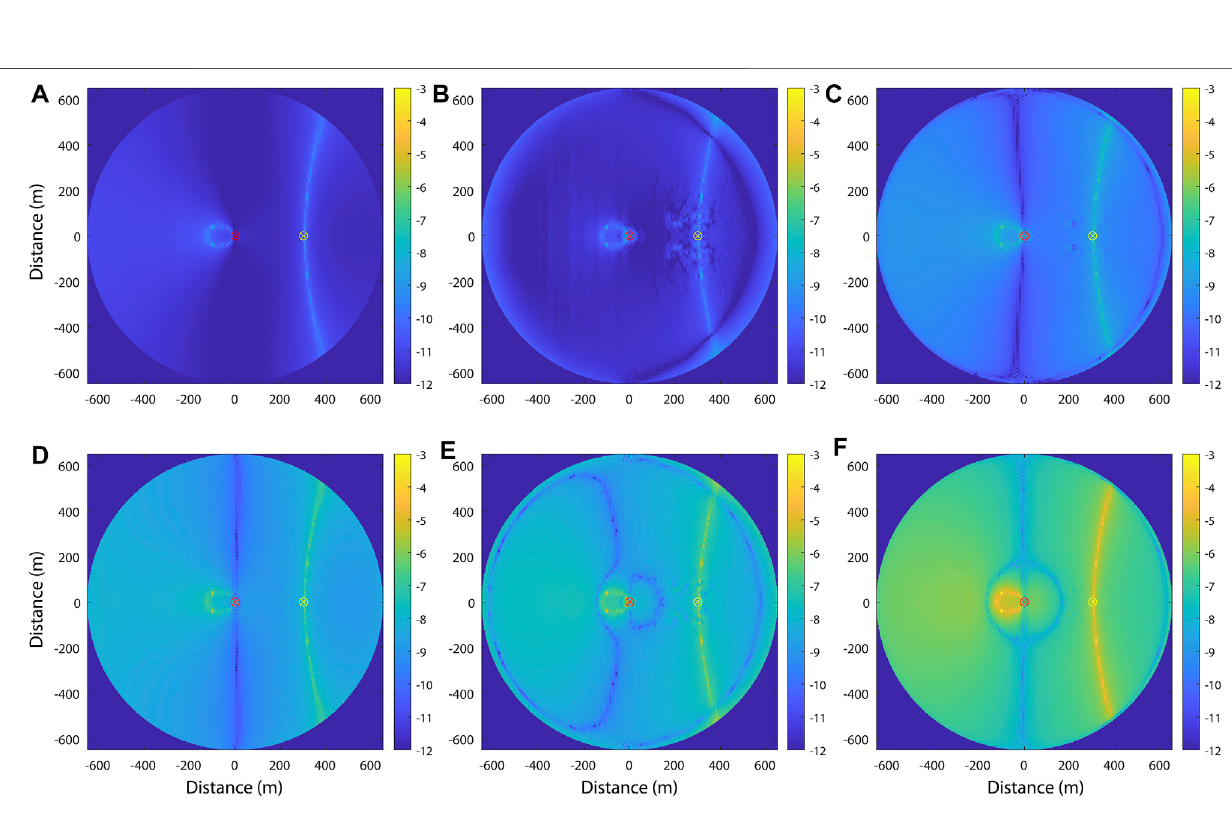
sample holder was used to scan the sample between 2 and 55 ° (2 θ ) using a Cu-K α source (giving x-rays of wavelength 1.54 Å) and LYNXEYE_XE (1D mode) detector for 45 min of exposure time.